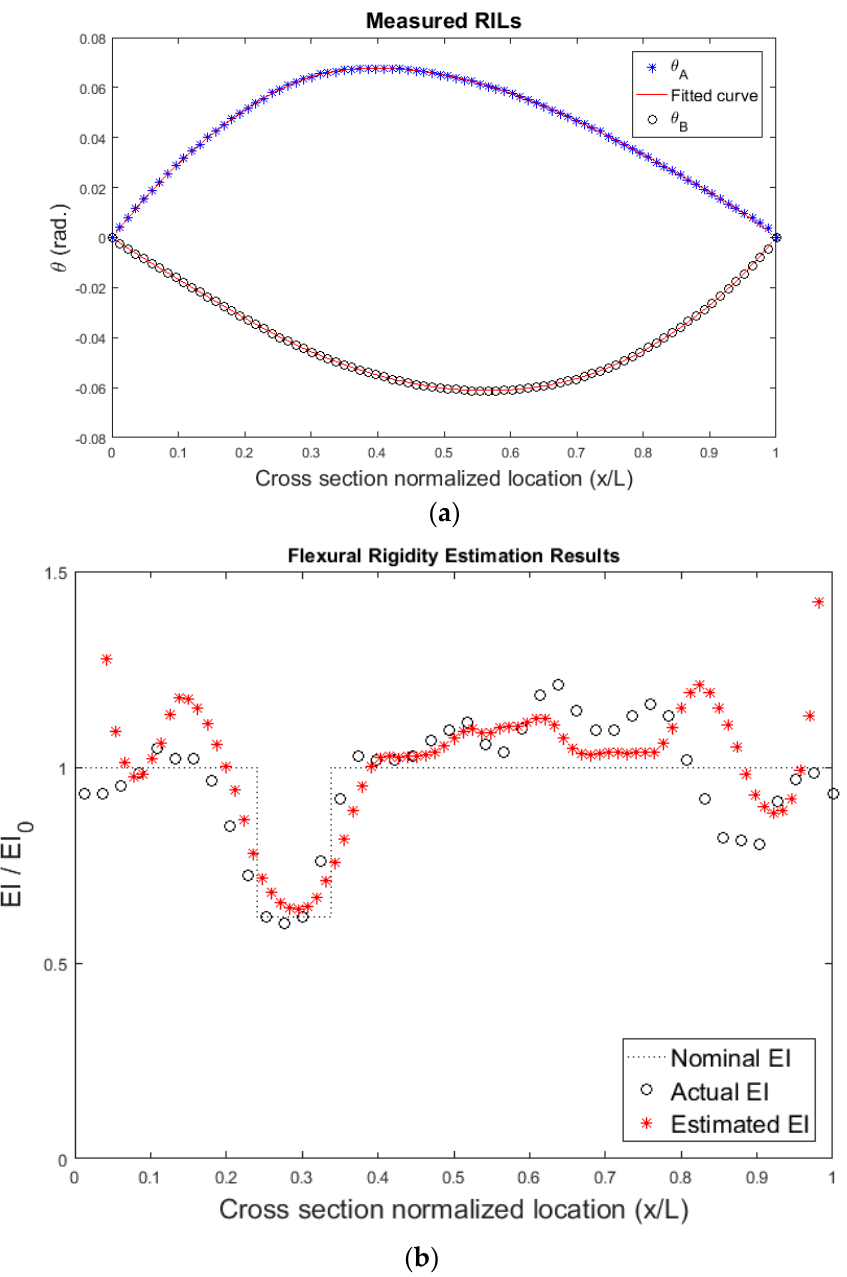
Figure 11. Experiment results, ( a ) measured RILs and fitted curves, ( b ) Results of flexural rigidity estimation.